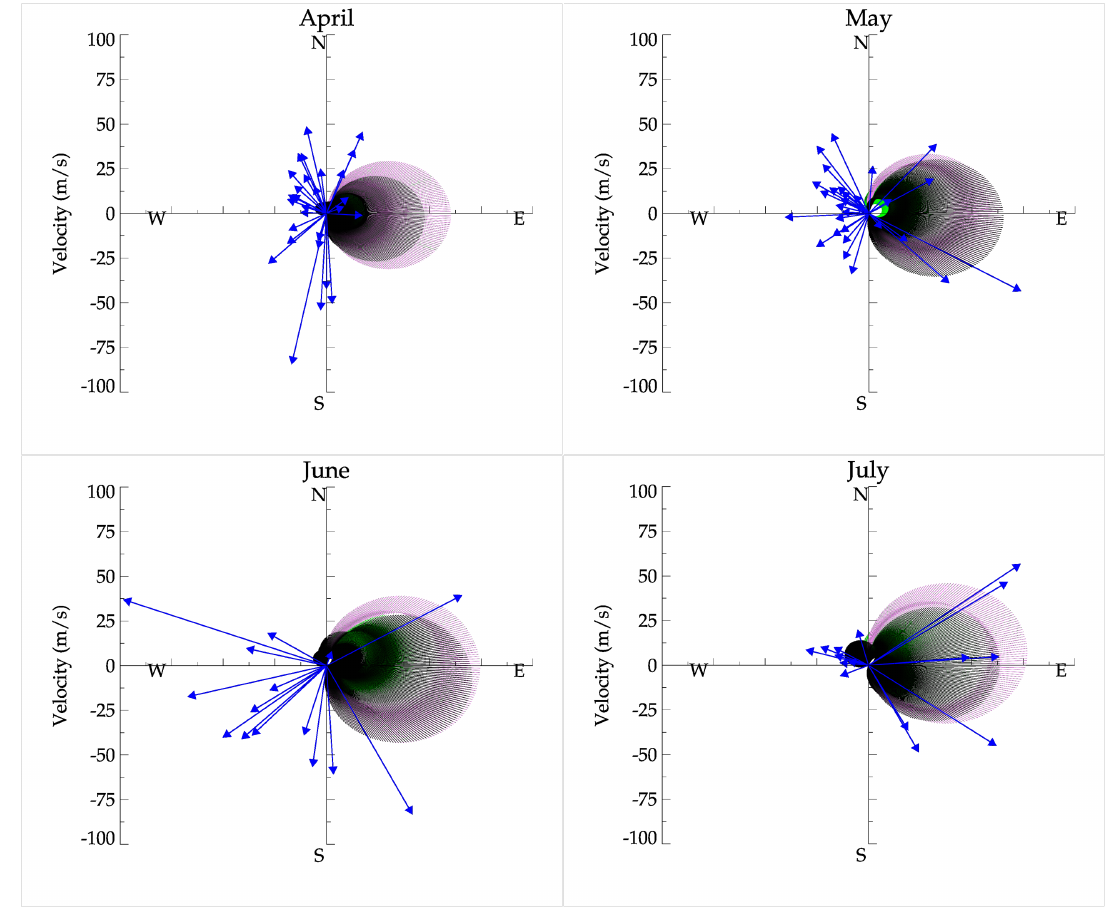
Figure 9. Blocking diagrams from a top view of Figure 8. The blue arrows represent the gravity waves horizontal phase speed vectors, showing the velocity intensity and azimuthal direction (clockwise from north). Colors of the blocking regions are the same as Figure